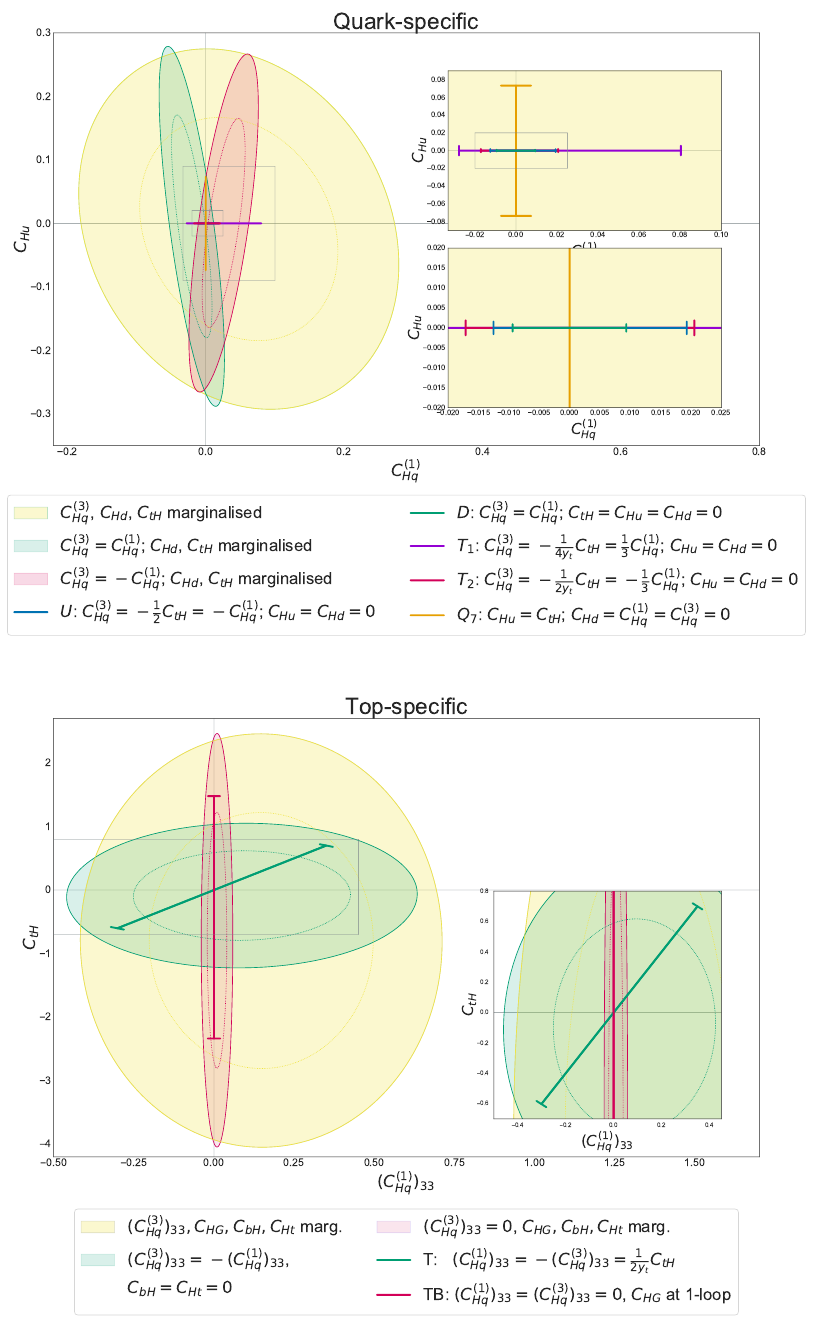
Figure 16 . Constraints at the 95% CL on ( C (1) (( C (1) ) ) in the top-specific scenario. The lines correspond to the 2 σ limits obtained when 33 , C tH Hq the operator coefficients are restricted to the relations generated by integrating out single-field ex- tensions of the